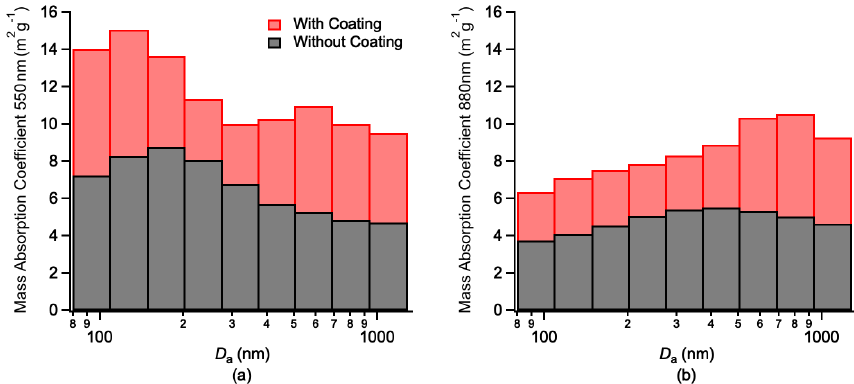
Figure 9. Mass absorption coefficient (MAC) at (a) 550nm and (b) 880nm wavelength for coated and uncoated rBCc.